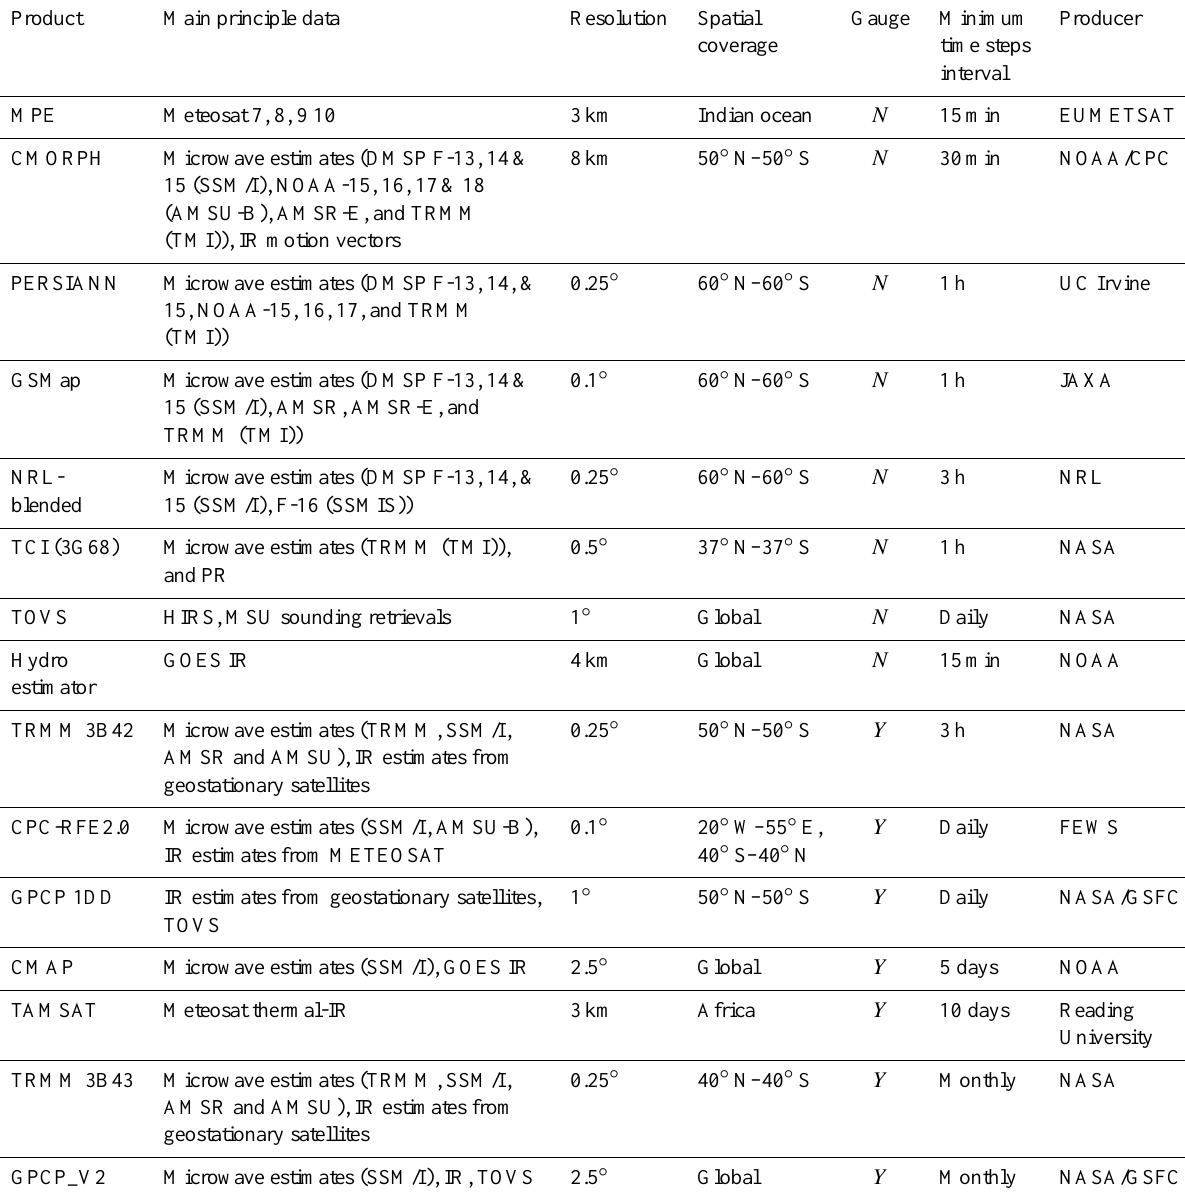
Table 1. Overview of the main existing regional and global-scale satellite-based data sources of rainfall. The column “gauge” indicates whether a calibration against ground data is